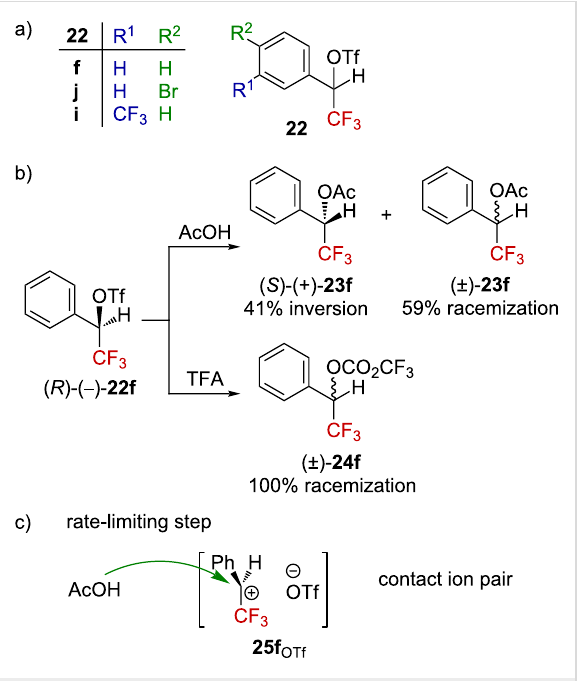
Figure 5: a) Structure of triflate derivatives 22 . b) Stereochemistry outcomes of the reaction starting from ( R )-( − )- 22f . c) Rate-limiting step in poorly ionizing solvents.